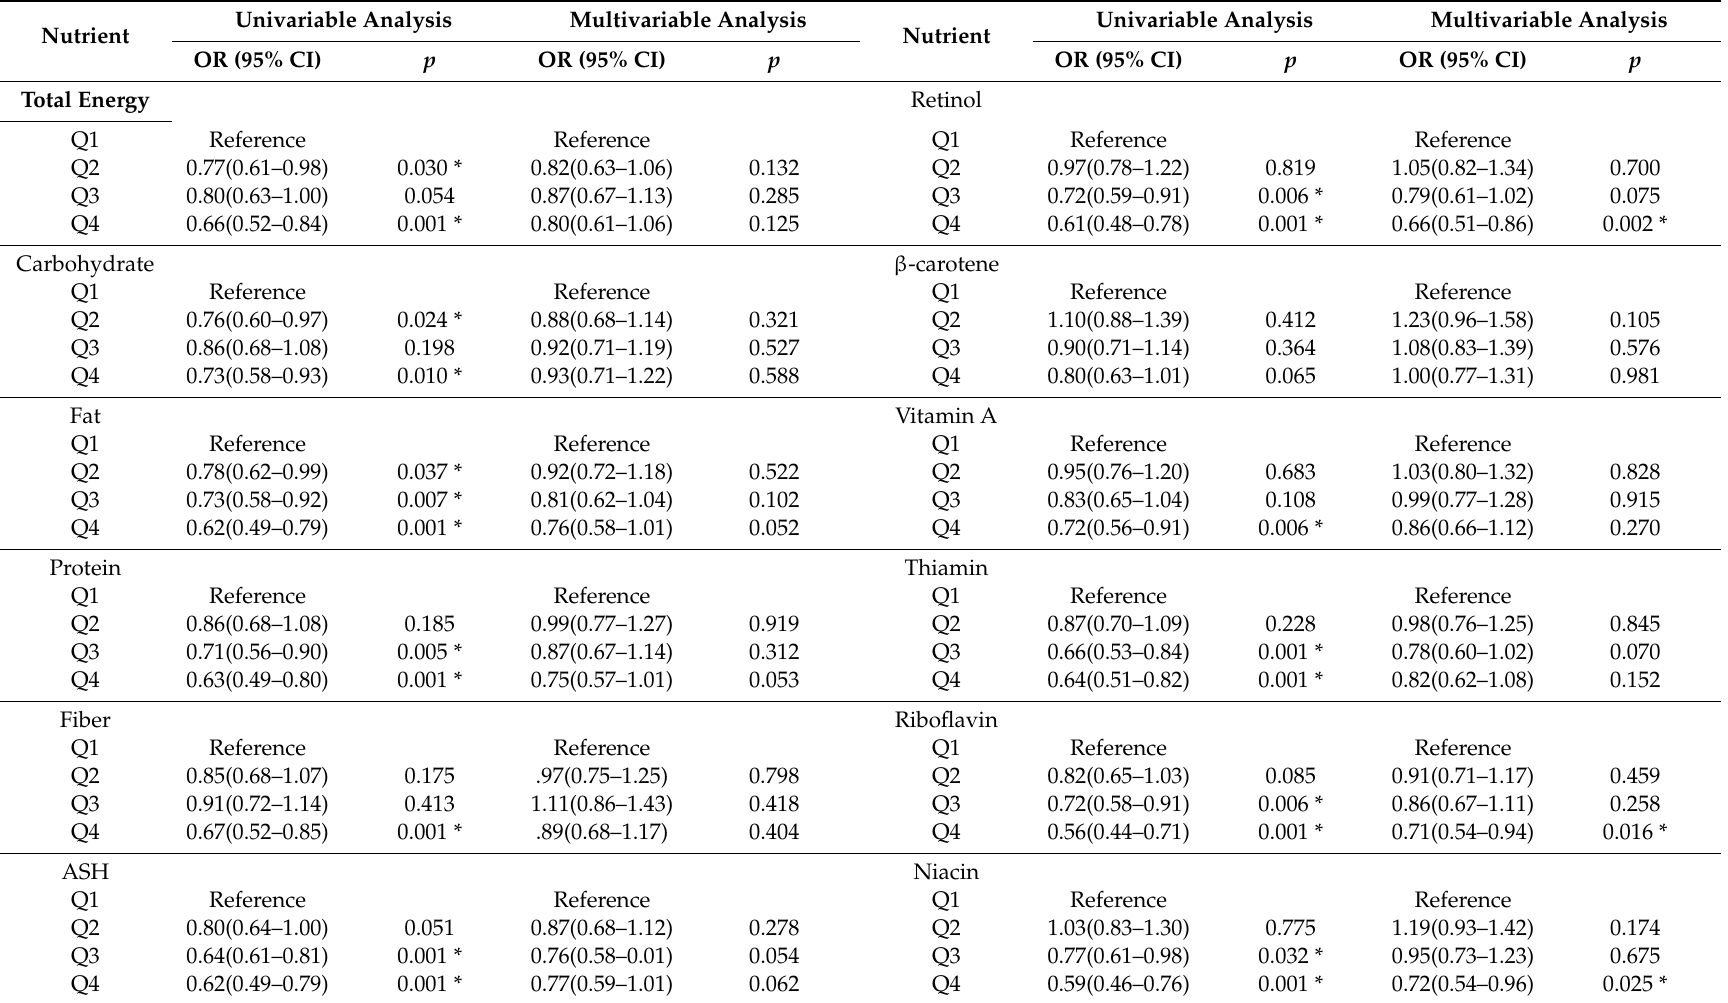
Table 3. Odds ratios of nutritional factors and bilateral hearing